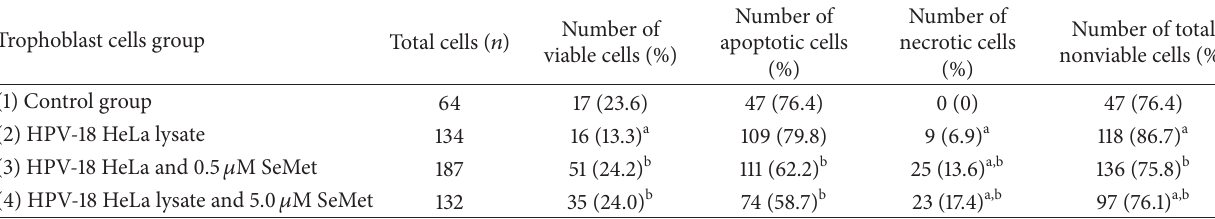
a Different from the control (1) group ( 𝑝 < 0.05 ).